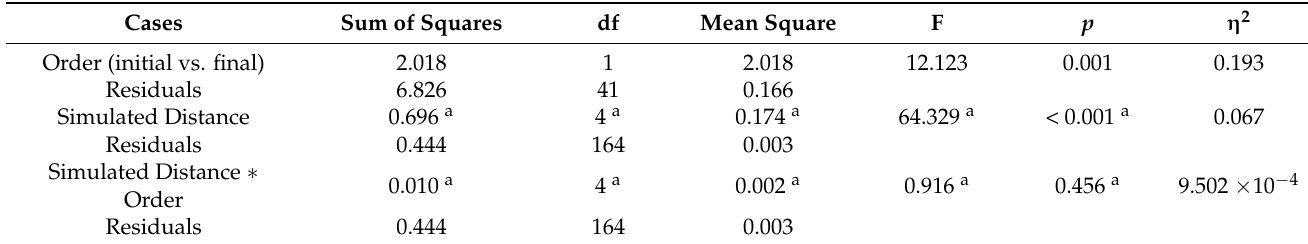
Table A7. Exp 3: Group 2—repeated-measures ANOVA—comparing target sizes.